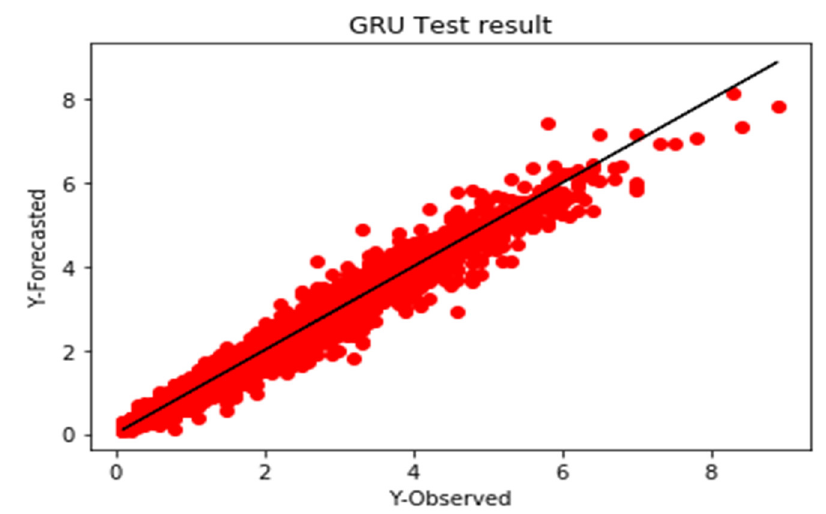
Figure 22. GRU-based wave height model error analysis.